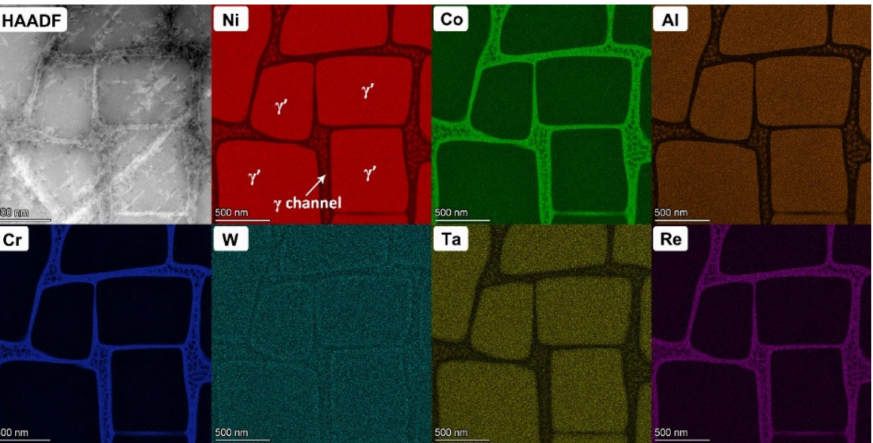
Figure 5. Element mapping of γ matrix and γ ’ precipitates in the dendrite cores at the cross sections close to the fracture surface of DZ406 superalloy tested at − 125 ◦